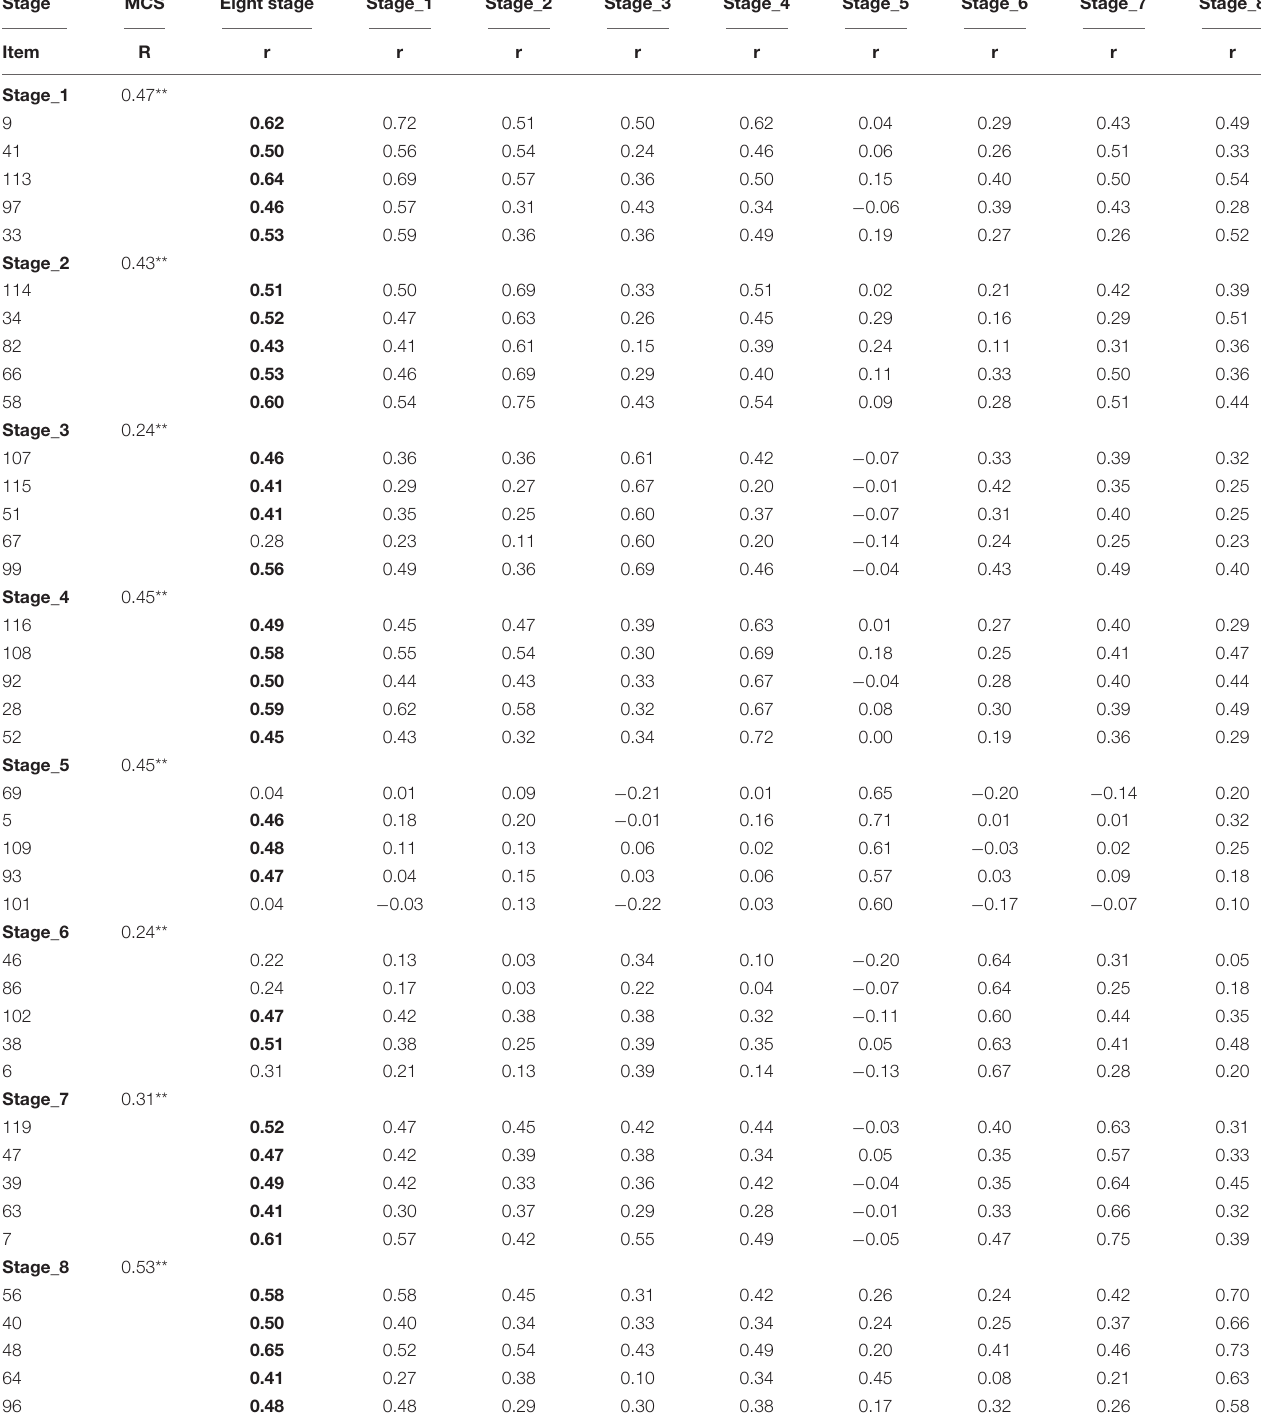
TABLE 4 | Correlation among each item of subscale, all stages in CIPB-SF, and MCS ( N = 308).